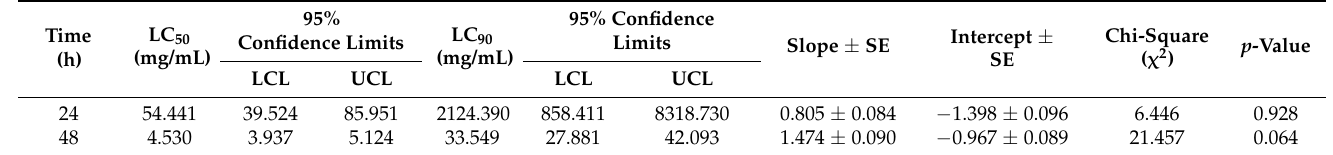
Figure 1. ( A ) The 50% and 90% log transformed lethal concentration values log(LC 50 and LC 90 ) ± its log-transformed confidence limits log(LCL and UCL) of larval mortality; ( B ) The log-transformed lethal time values for 50% and 90% lethality of larvae log(LT 50 and LT 90 ) ± its log-transformed confidence limits log(LCL and UCL), ( C , D ) show the one-way ANOVA and post hoc Tukey test showing the significant difference in varying concentrations of %IO and larval mortality, respectively (Bars containing no similar letters are significantly different by Tukey’s HSD test at the 5% level of significance ( p < 0.05)). Table 2. The 50% and 90% lethal concentration values of Pinus roxburghii on the in vitro R. ( B. ) microplus larval mortality at 24 and 48